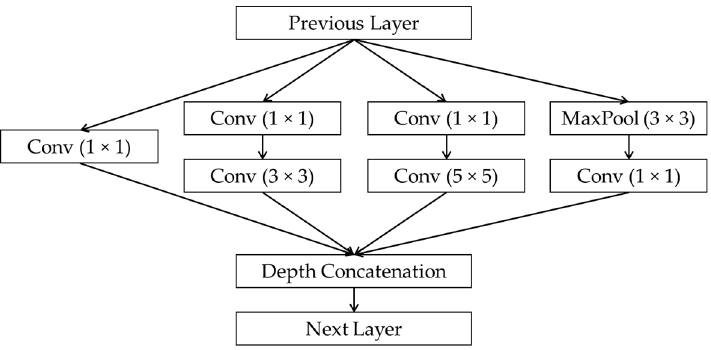
Figure 4. Structure of the Inception module.